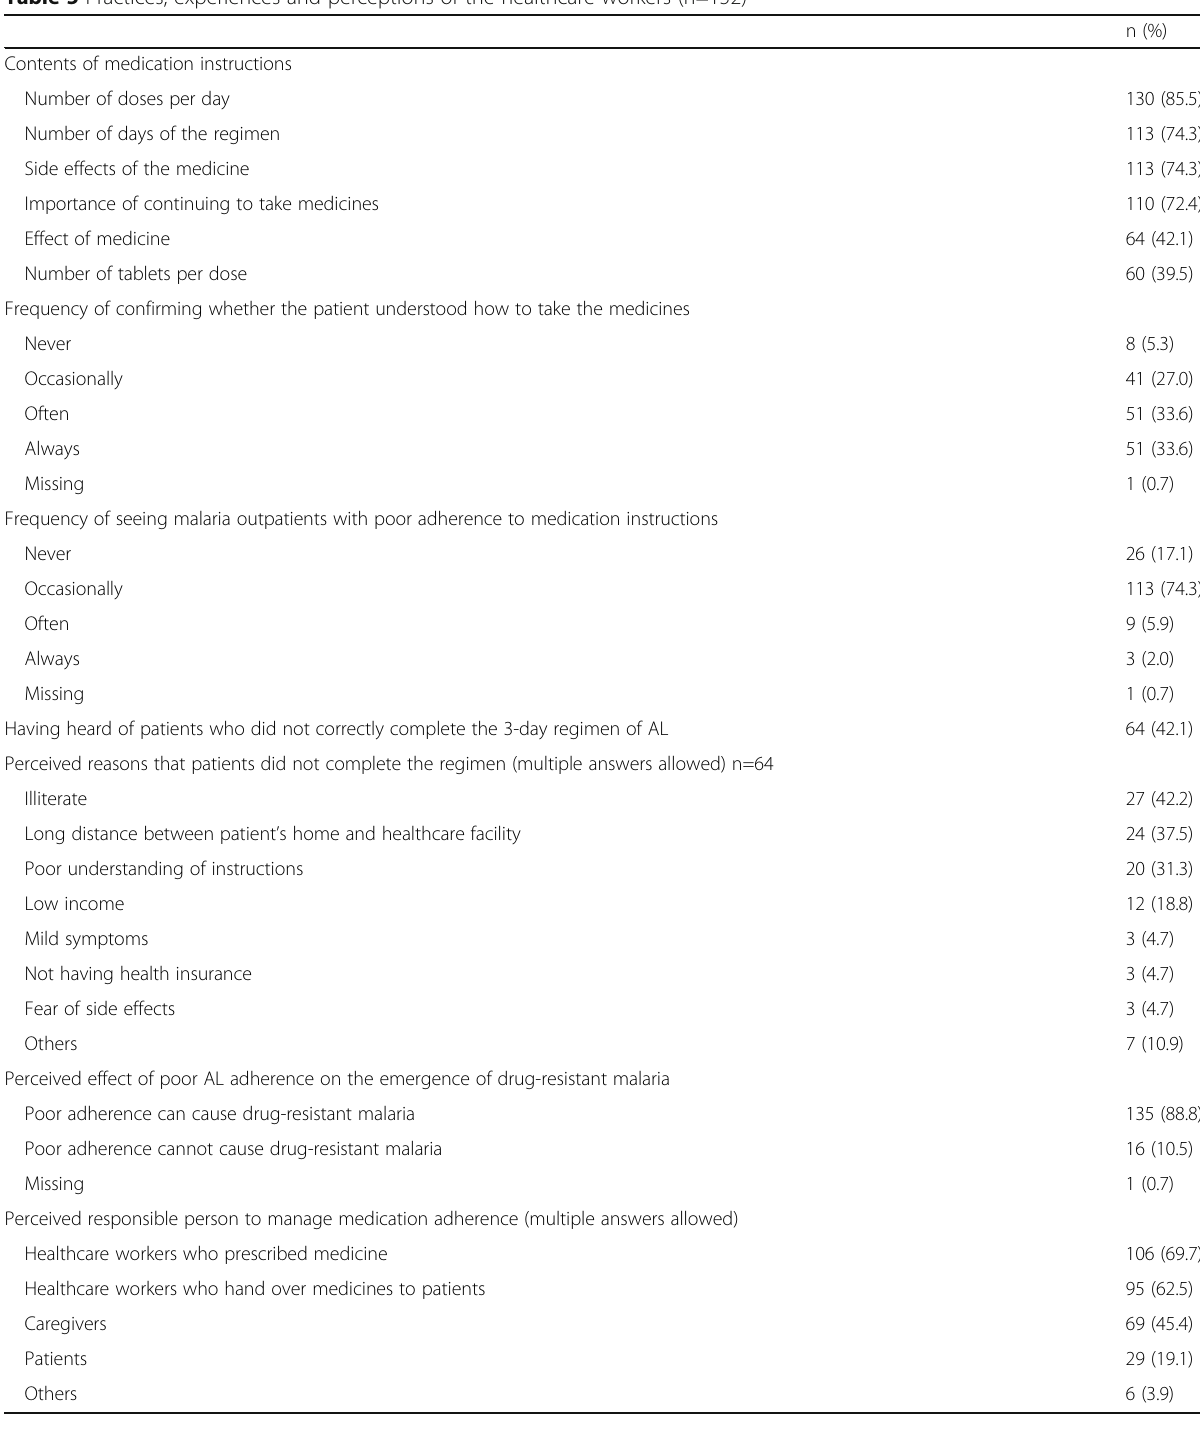
Table 5 Practices, experiences and perceptions of the healthcare workers